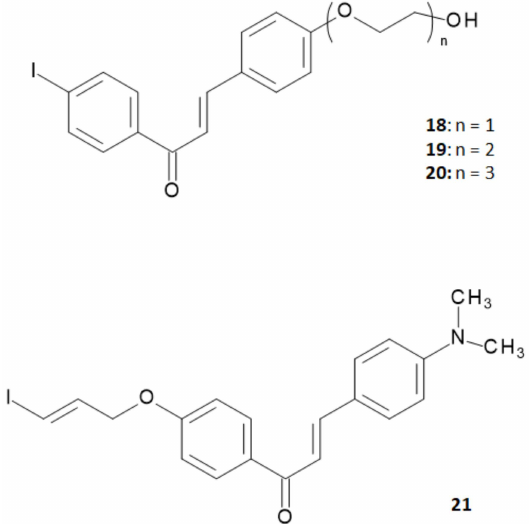
Figure 7. Structure of chalcone derivatives containing ethyleneoxy chains in para -position of 3-phenyl ring or an iodoallyloxy group in para -position of 1-phenyl ring.